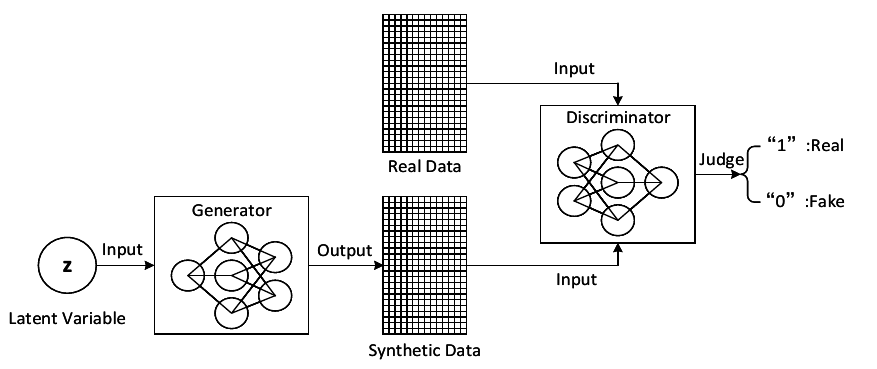
Figure 3. The structure of